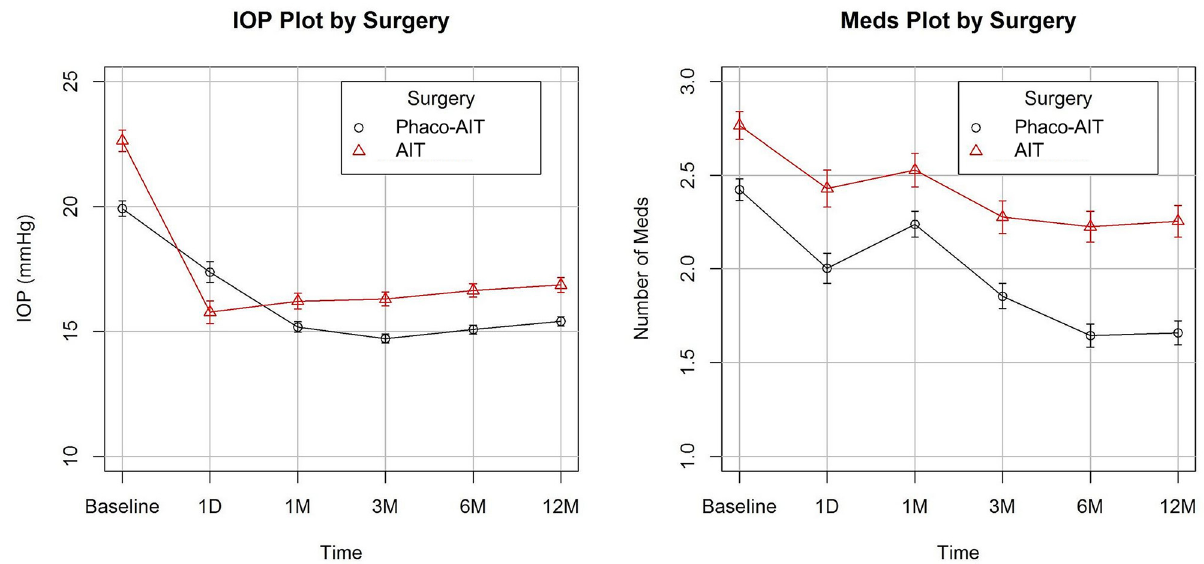
Fig 2. IOP and medication plots. Preoperative and postoperative intraocular pressure (IOP; left) and number of glaucoma medications (Meds; right) over the 12 month follow-up for both groups. Represented as mean ± standard error. Statistically significantly different at all time points for both plots (p <